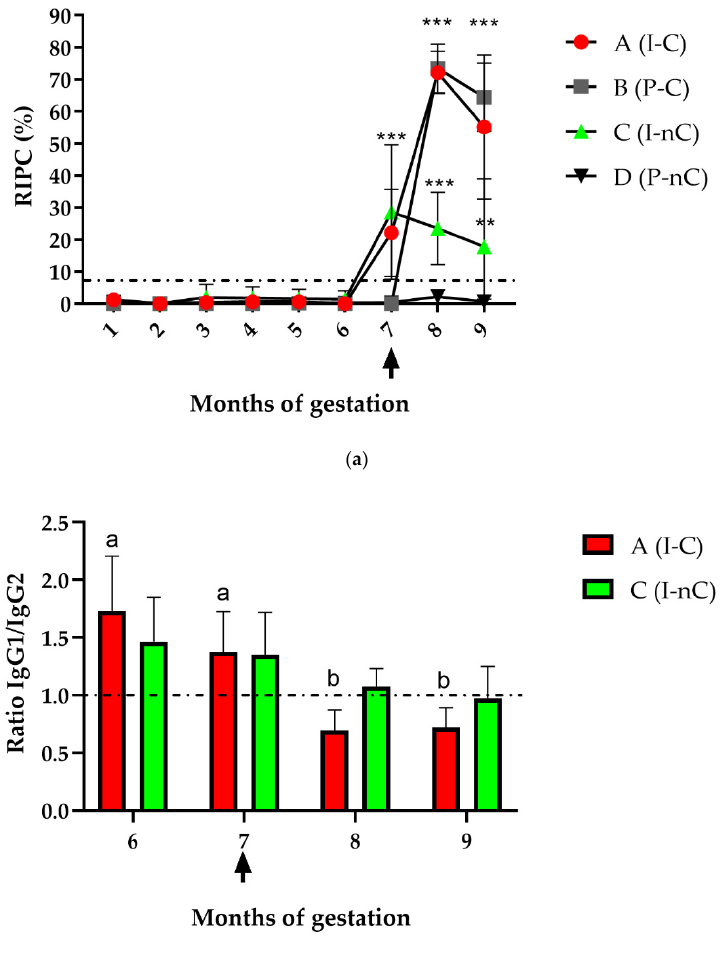
Figure 2. Longitudinal profile of immunoglobulin G (IgG) and subisotypes in heifers from different experimental groups assessed by iELISA. Each dot represents the mean ± standard deviation (SD) at different sampling times. ( a ) Mean ± SD of the relative index percentages (RIPC) ± SD of total IgG throughout gestation in Groups A (inoculated and challenged (I-C)), B (placebo and challenged (P-C)), C (inoculated and not challenged (I-nC)), and D (placebo and not challenged (P-nC)). Cut-off: ≥ 8.2 RIPC. *** p < 0.0001. ** p < 0.001. The upwards arrow marks the day of challenge (210 days of gestation). ( b ) Mean Neospora -specific IgG1/IgG2 ratio ± SD of animals in Groups A and C at 6, 7, 8, and 9 months of gestation. Lowercase letters indicate significant differences within the same group over time. The upwards arrow marks the day of challenge (210 days of gestation).